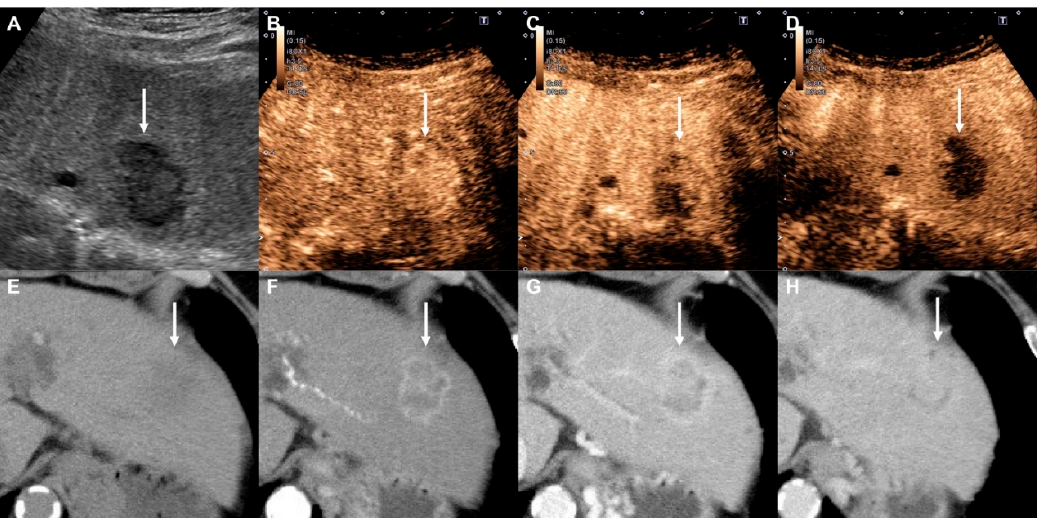
Figure 4. Intrahepatic cholangiocarcinoma in a 69-year-old woman with alcoholic cirrhosis. ( A ) Gray-scale ultrasound shows a hypoechoic mass (arrow) in the liver. ( B ) The nodule (arrow) shows homogeneous hyperenhancement at 24 s in the arterial phase of Contrast-Enhanced Ultrasound (CEUS). ( C ) Early washout is apparent (arrow) at 40 s in the portal venous phase. ( D ) The nodule (arrow) shows a contrast defect in the Kupffer phase. ( E ) Pre-contrast CT shows a subtle hypodense mass (arrow). ( F ) The mass shows ring enhancement (arrow) in the arterial phase of Contrast-Enhanced CT (CECT). ( G , H ) Intratumoral enhancement (arrows) gradually increases in the portal venous and equilibrium phases.